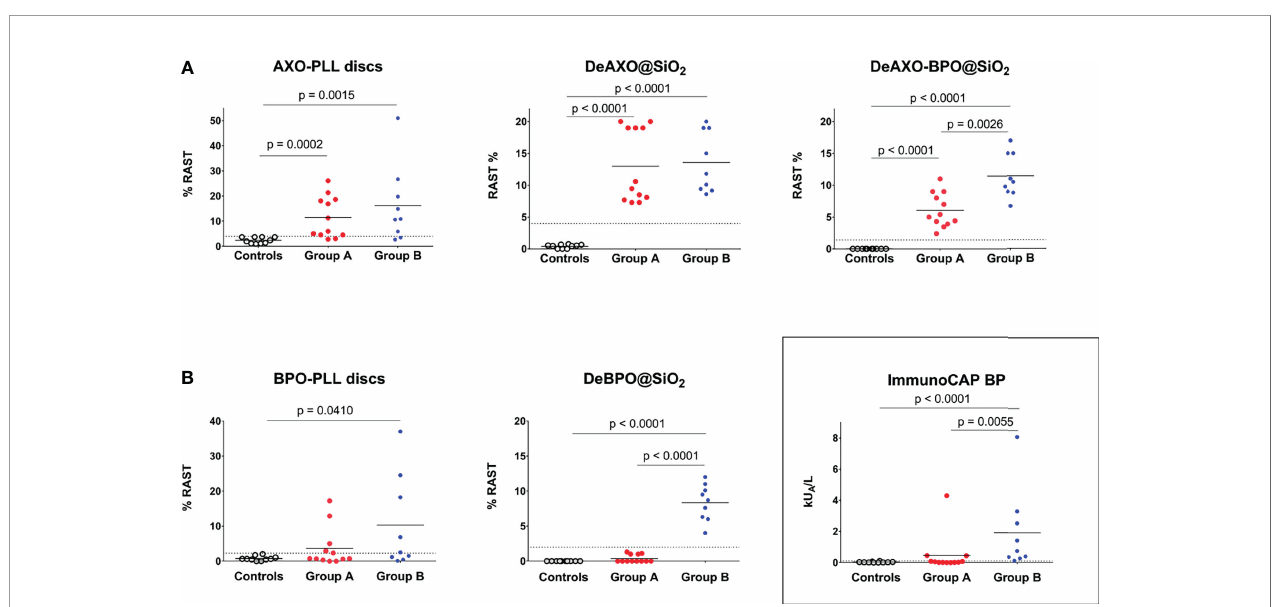
FIGURE 2 | Comparison of different immunoassays fpr BL-sIgE determination. (A) AX-sIgE determination using AXO-PLL-discs and DeAXO@SiO 2 as solid phases in RAST method. Determination of AX-sIgE and BP-sIgE using DeAXO-BPO@SiO 2 solid phases. (B) BP-sIgE determination using the three approaches: ImmunoCAP, BPO-PLL-discs and DeBPO@SiO 2 . Dot plots graphs show individual results for the 3 groups of subjects: tolerant to BLs (controls), AX-selective patients (Group A), and BP-AX cross-reactors (Group B). Positive results are considered over cutoffs (dashed line). Comparisons of quantitative variables without a normal distribution were done by the Mann-Whitney and Kruskall-Wallis tests. Signi fi cant differences were considered when p < 0.05, applying Mann-Whitney test for non-related samples.